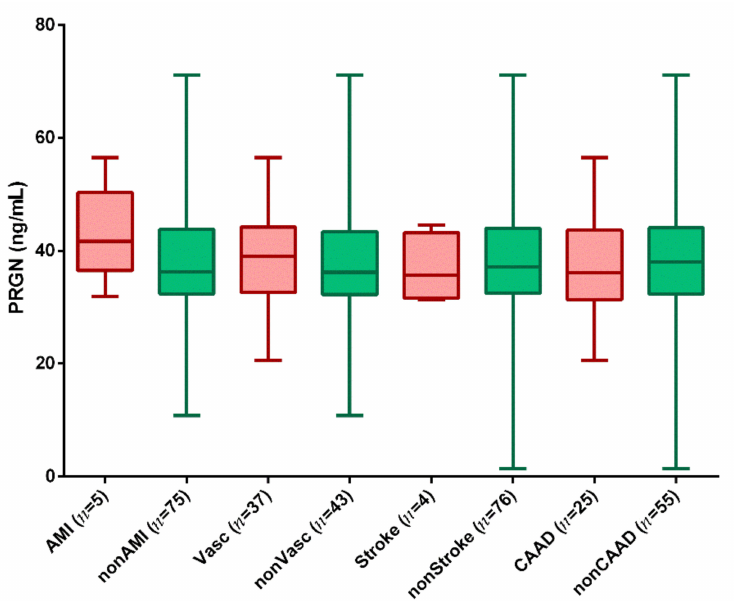
Figure 4. Boxplots showing serum progranulin (PGRN) in HeFH patients with and without previous acute myocardial infarction (AMI vs. nonAMI), with and without previous vascular complica- tions (Vasc vs. nonVasc), with and without previous stroke (Stroke vs. nonStroke) and with and without carotid artery atherosclerotic disease (CAAD vs. nonCAAD). Box, mean ± SD; whiskers, mean ± 1.96